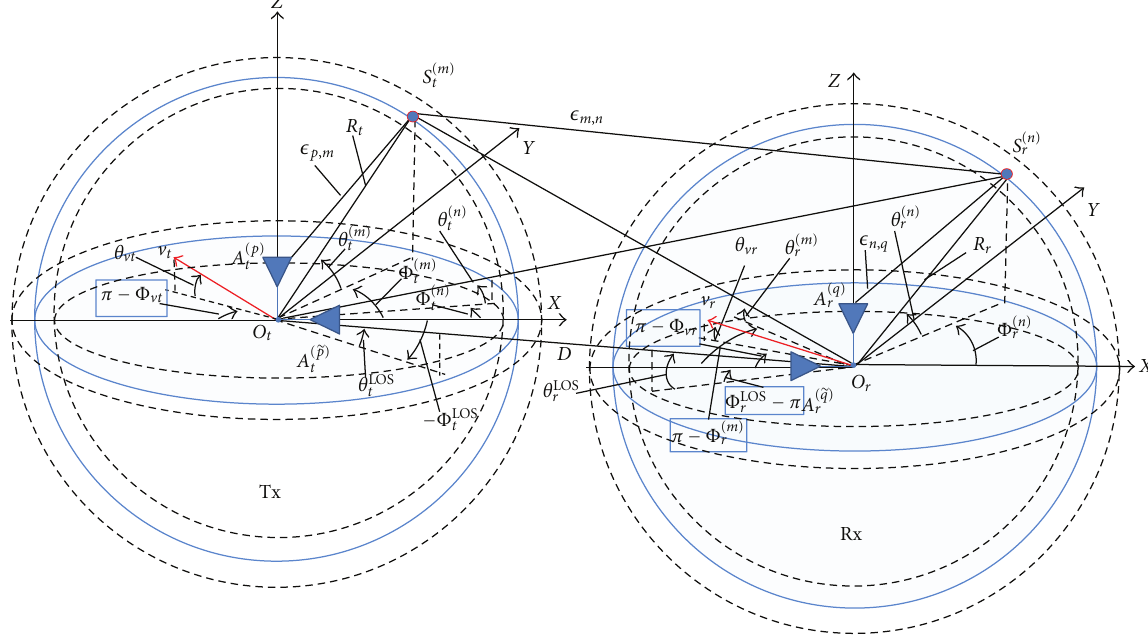
Figure 1: Concentric-spheres for 3D colocated DP channel model. The signals from the Tx antennas arrive in parallel at the Rx antenna